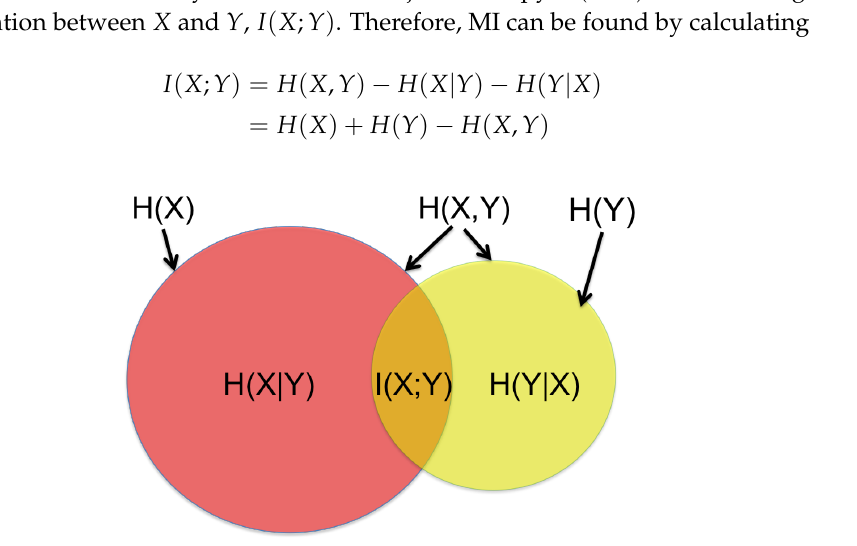
Figure 2. Venn diagram of entropy properties. I ( X , Y ) is the mutual information between entropy X and Y , symbolised by H ( X ) and H ( Y ) ,